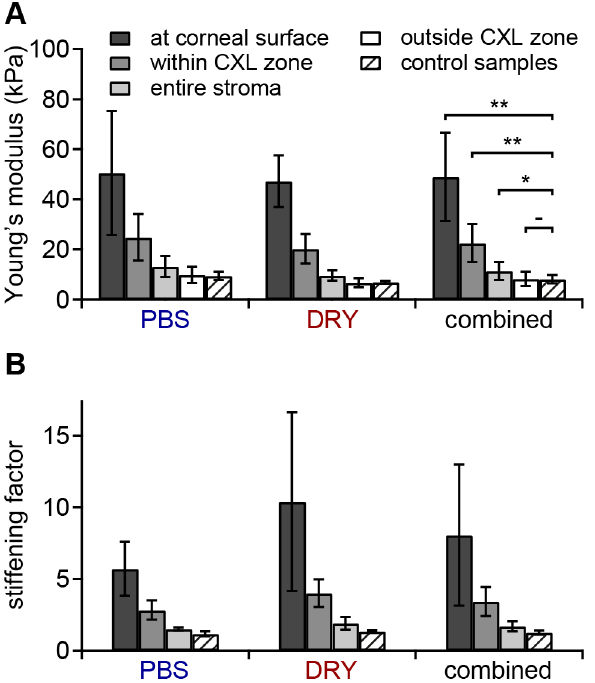
Figure 5. Young’s moduli and stiffening factors. A ) Mean YM at the corneal surface (anterior 25 m m), in the CXL zone, in the entire stroma, and outside the CXL zone. Control samples are included for comparison. Stars indicate a significant difference (* p , 0.05, ** p , 0.01, - not significant). B ) Mean stiffening factors as determined by division of the YM of each sample in the region of interest (see A) by the YM of the posterior 100 m m. Error bars indicate the standard deviation.